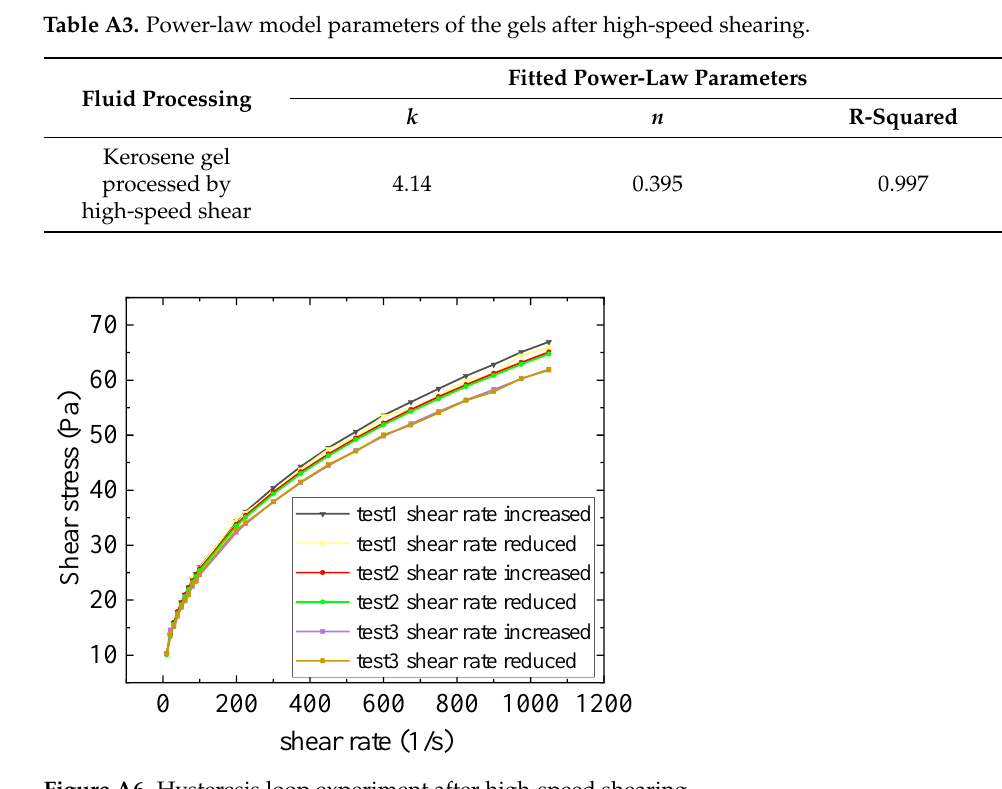
Figure A6. Hysteresis loop experiment after high-speed shearing.